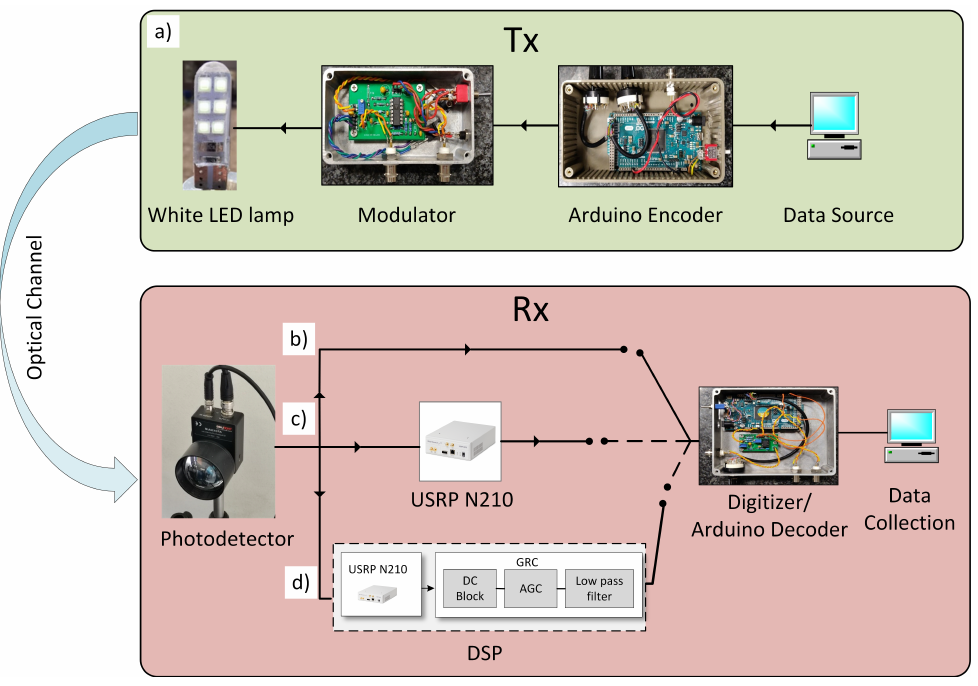
Figure 1. VLC system block diagram: ( a ) The upper panel shows the block diagram of TX hardware, including the data packet generator and current modulator, which supplies the automotive LED lamp. The lower panel shows the VLC RX hardware system used for the three configurations analyzed (see text): ( b ) Direct Arduino System , ( c ) Bridge System, and ( d ) Full System . For all three configurations, the digitization and decoding process is performed by the Arduino RX Digitizer/Decoder board, which also performs a byte-wise comparison for PER